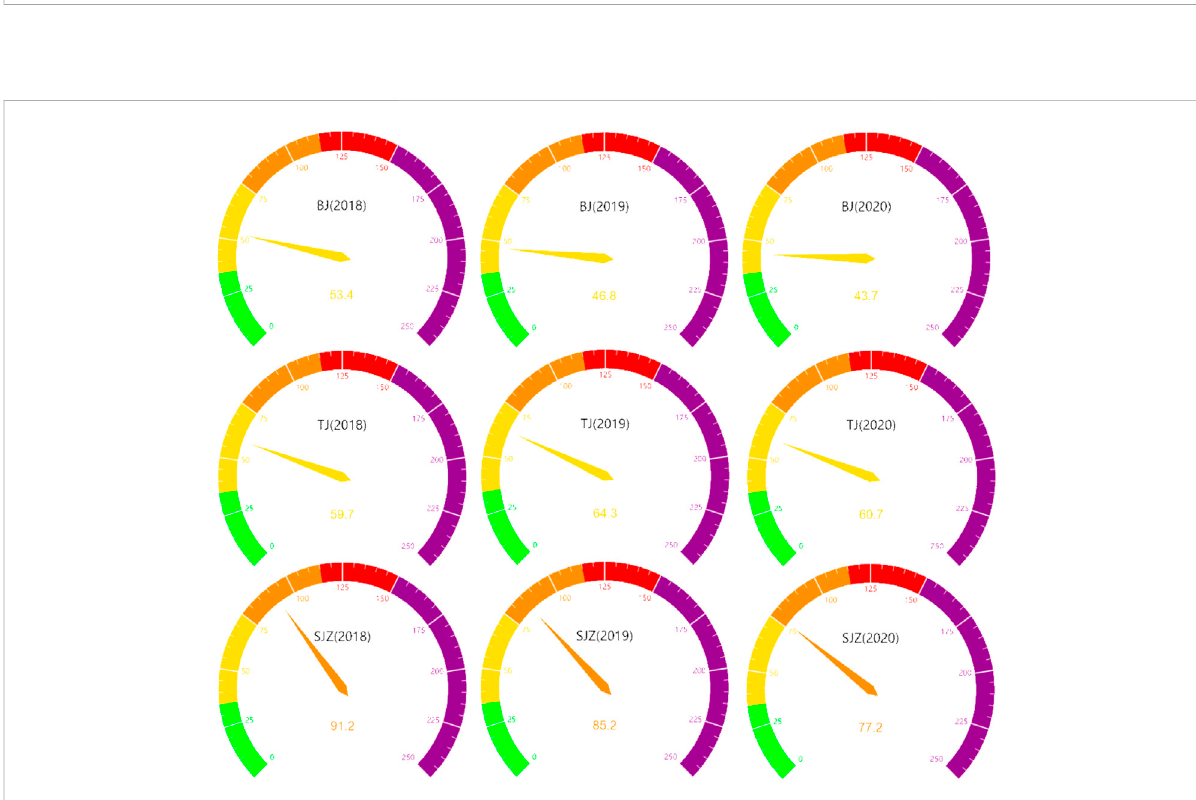
FIGURE 4 Observations of PM 2.5 concentrations in Beijing, Tianjin and